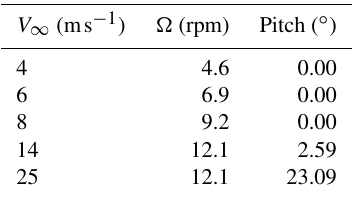
Figure 8. Downwash at an elliptical wing predicted by AL simula- tions with different smearing factors and smearing correction. The CFD components of the velocities are shown (dashed) as well as the total downwash incorporating the correction (solid). The theoretical value acts as reference. Table 2. Input parameters for the NREL 5-MW